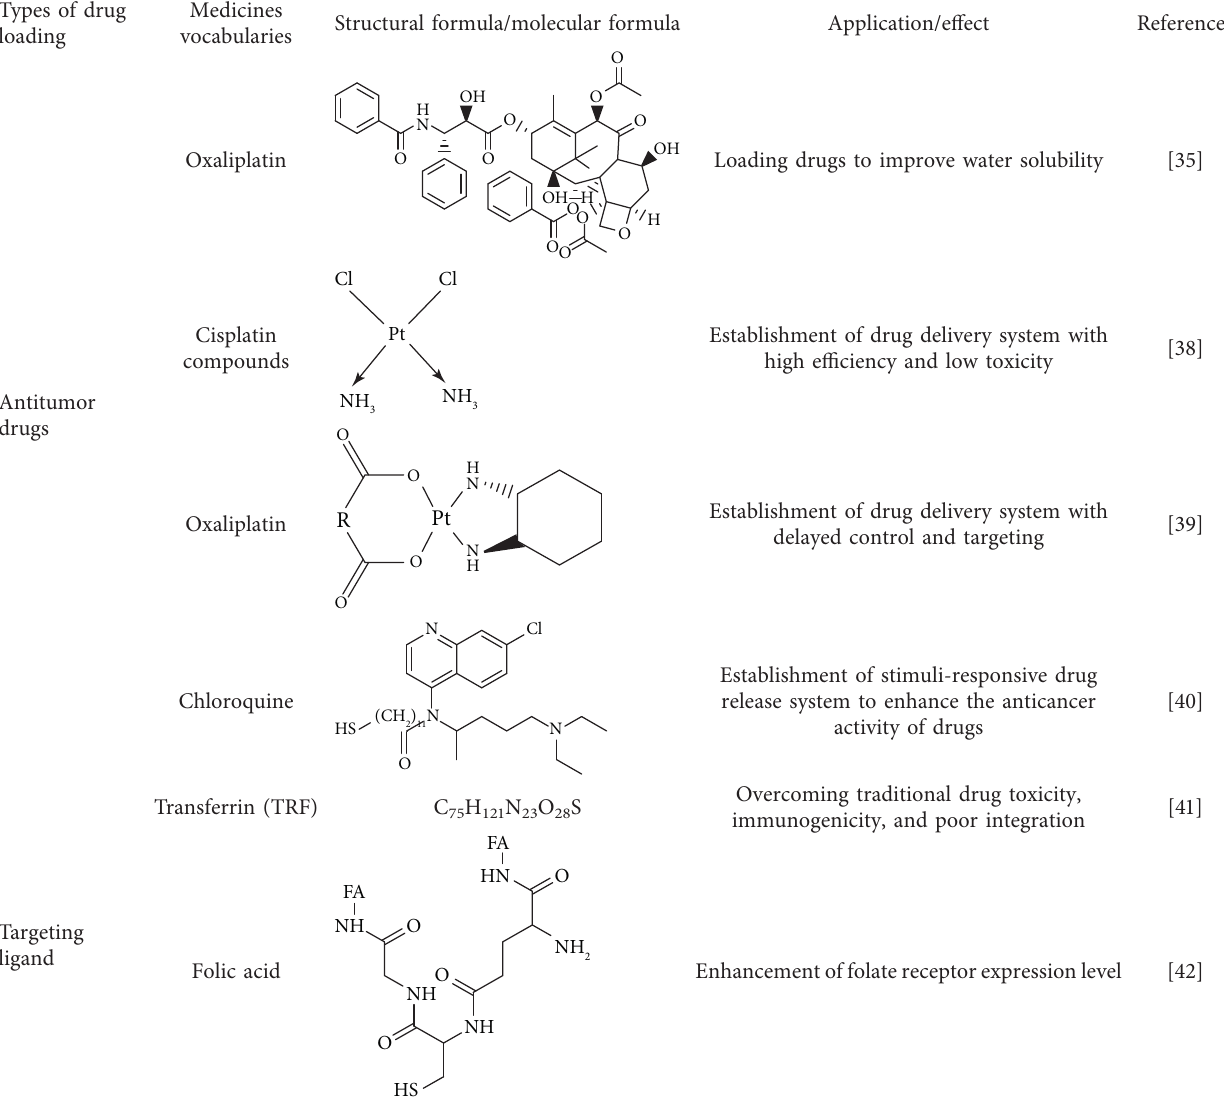
Figure 2: SEM images of gold NPs capped with Croton caudatus Geisel leaf extract (Vijaya Kumar et al. [28]). Table 1: Clinical application of gold nanoparticles as drug